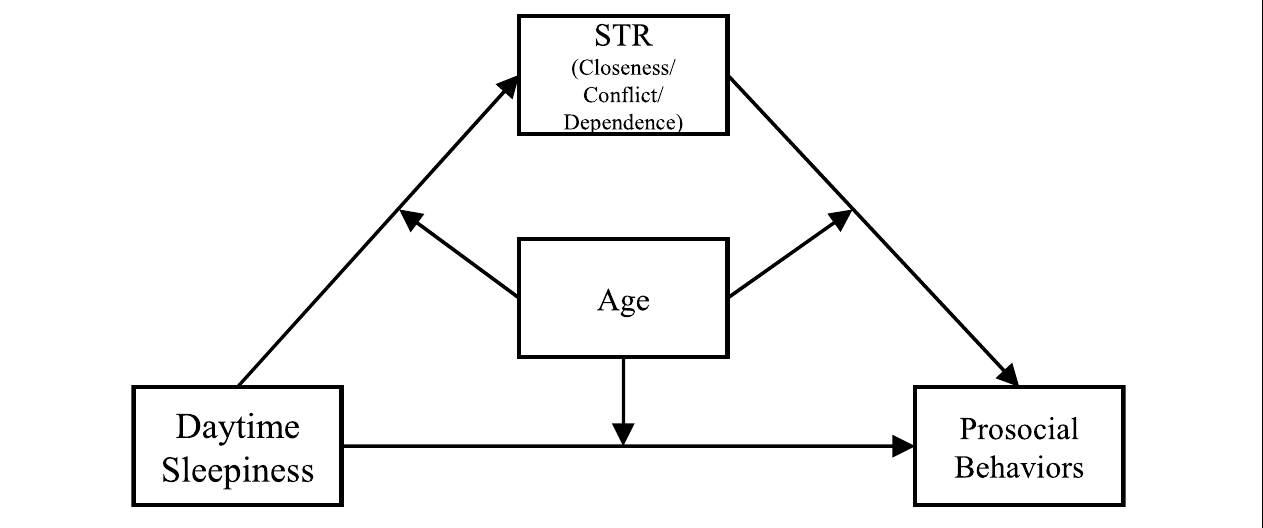
FIGURE 1 | The hypothesized moderated mediation model. STR, student-teacher